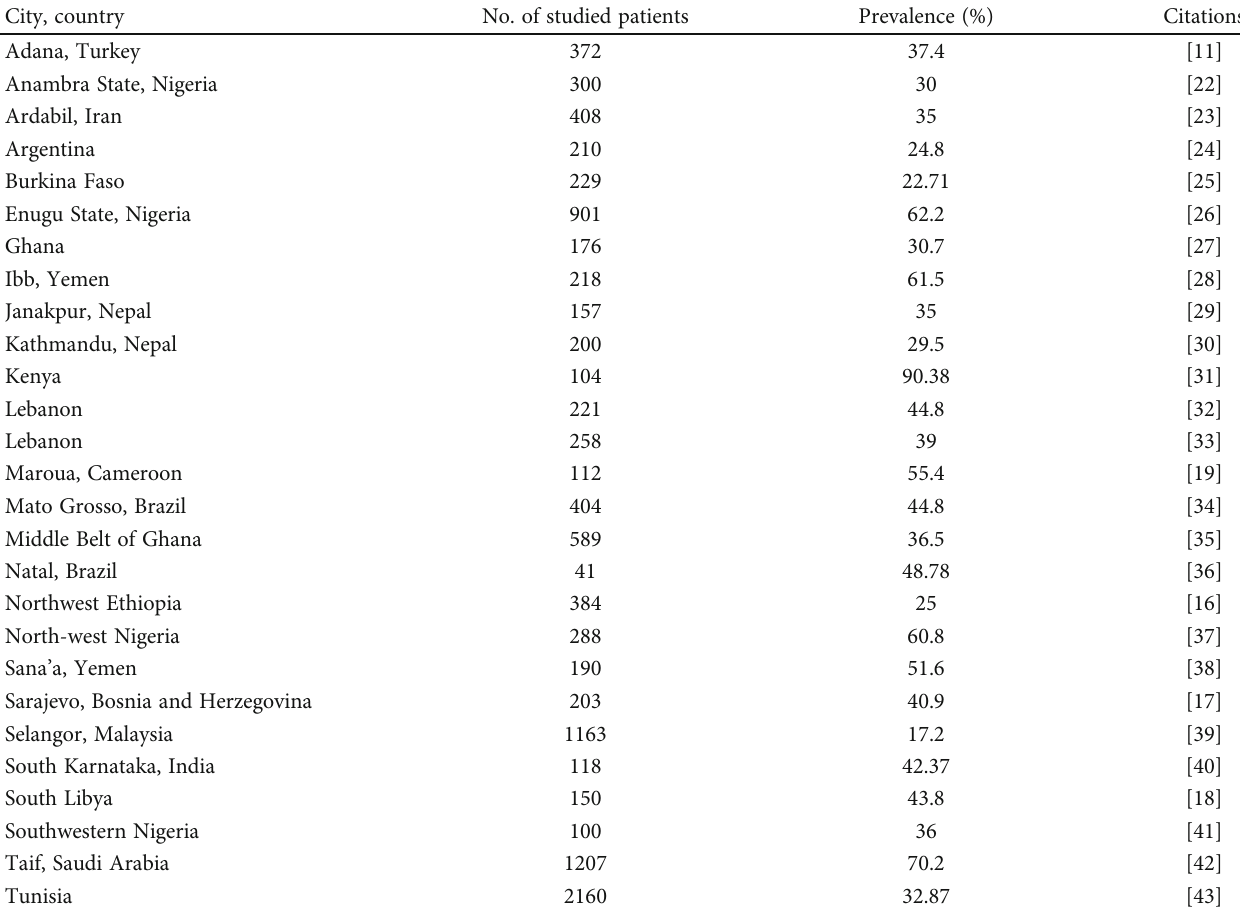
Table 1: The prevalence of VVC and/or positive vaginal candida colonization during pregnancy in di ff erent regions of the world. City,